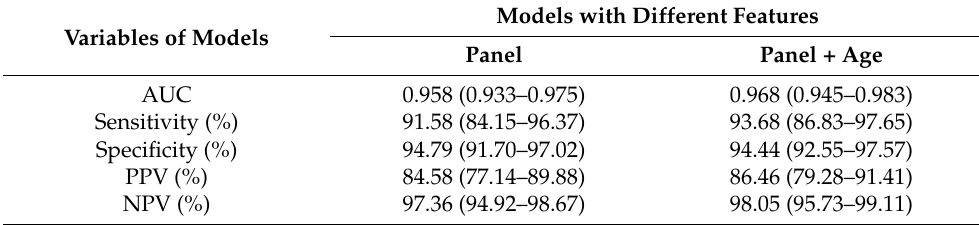
Table 3. The detection performances of different